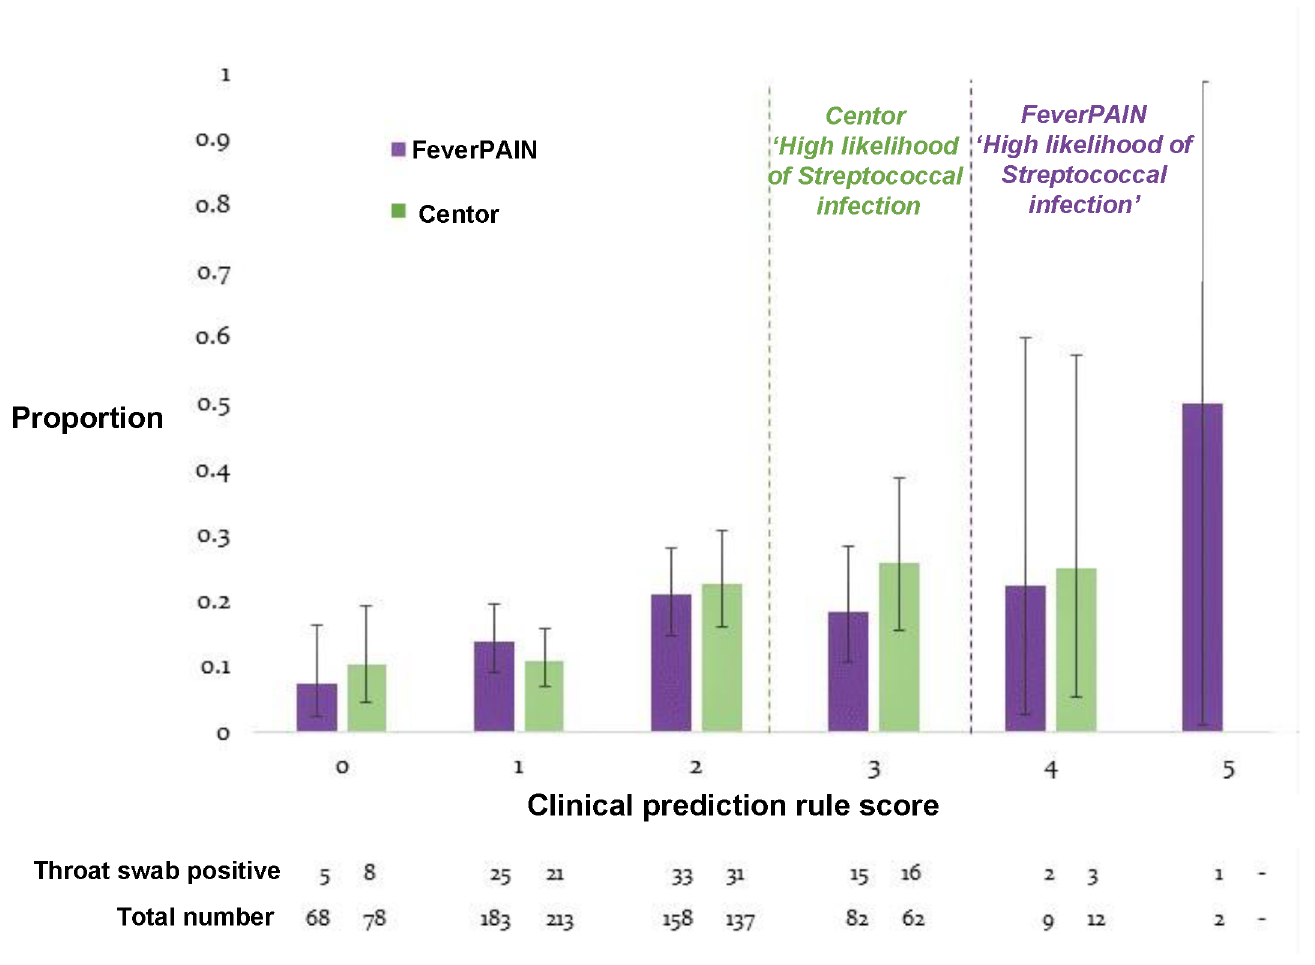
Figure 1 Proportion with throat swabs positive for streptococcal † infection. Proportion of those with streptococcal infection within each clinical prediction score, with 95% confidence intervals represented by black bars. Lines on the graph added for thresholds of Centor criteria ≥3 and FeverPAIN ≥4 indicating high probability of infection, where NICE supports consideration of antibiotic prescription. Data below the graph indicate the number of participants at each score, and number who were throat- swab positive for group A, C, or G streptococci. All beta- Lancefield group streptococci to include group A, C, and G streptococci strains isolated on agar plates after 48 hours